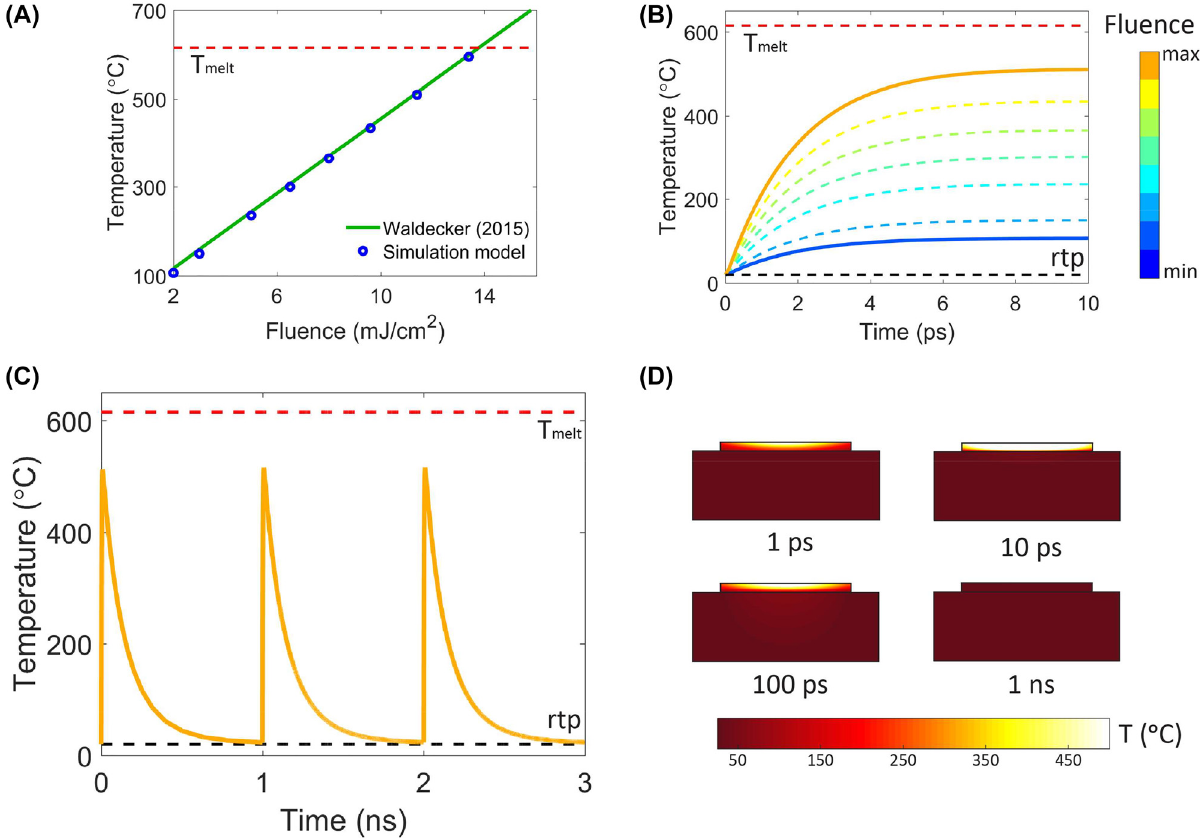
Figure 5: Two-temperature heat simulation of the crystalline Ge 2 Sb 2 Te 5 material when excited with femtosecond laser pulses. (A) Average temperature of the Ge 2 Sb 2 Te 5 fi lm after being exposed to the various laser fl uence used in Figure 3. (B) Corresponding variation of Ge 2 Sb 2 Te 5 temperaturewithtime.Boththetemperaturevaluesandheatdissipationratesmatchthosereportedinreference[13].(C)Averagetemperature of the Ge 2 Sb 2 Te 5 fi lm on AlN MRR waveguide when the NLAF is subjected to 1 GHz femtosecond laser pulse train. (D) Heat distribution cross- section of the Ge 2 Sb 2 Te 5 NLAF MRR at different times after being excited with a 35 fs laser